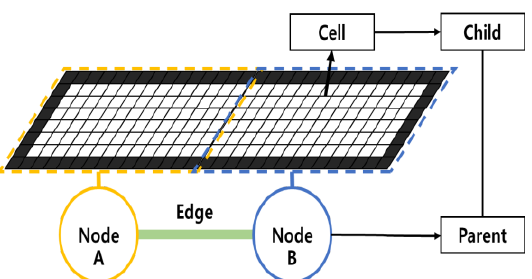
Figure 8. Hierarchical data structure of the improved FFM